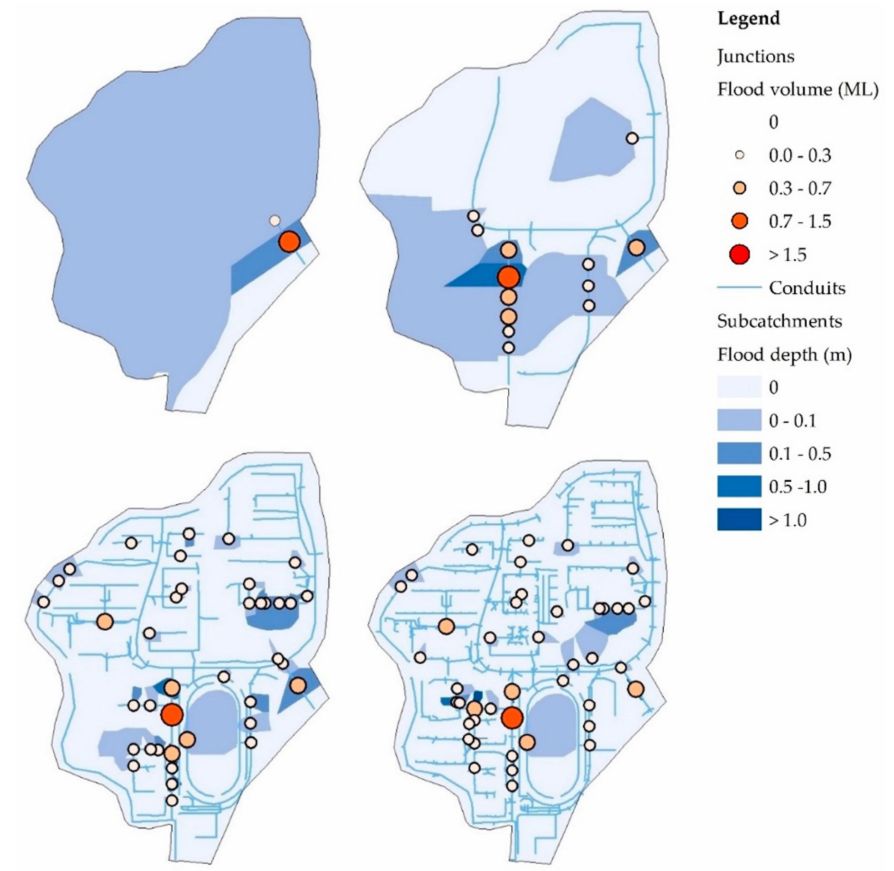
Figure 14. Distribution of the overflow junctions and flood area, flood volume of the overflow junctions, and flood depth of the flood subcatchments for the northern district. In the legend, “ML” represents a million liters, and “m” represents